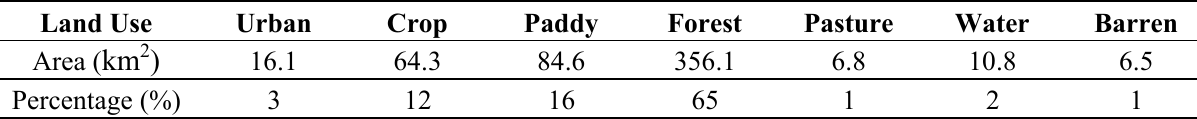
Table 1. Land use distribution in study